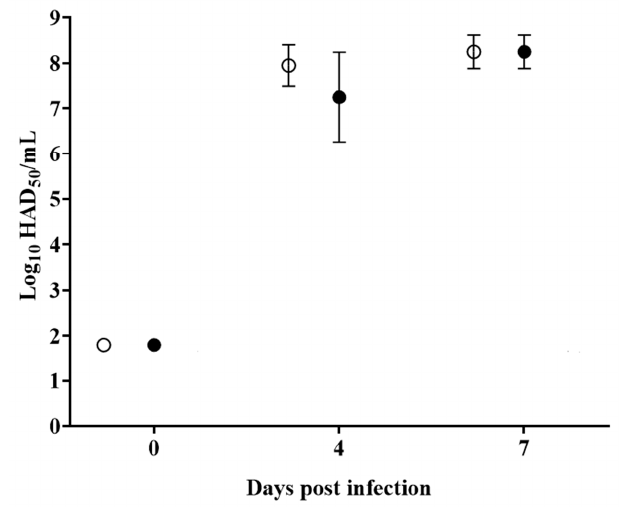
Figure 6. Viremia titers detected in pigs IM inoculated with 10 2 HAD 50 of either ASFV-G- ∆ C962R (filled symbols), or ASFV-G (empty symbols). Each symbol represents the average of animal titers in each of the groups. Sensitivity of virus detection: > log10 1.8 TCID 50 / mL . No significant di ff erences in viremia values between both groups of pigs were found at any sample time tested using the Holm–Sidak method ( α = 0.05) without assuming a consistent standard deviation. All calculations were conducted on the software GraphPad Prism version 8.